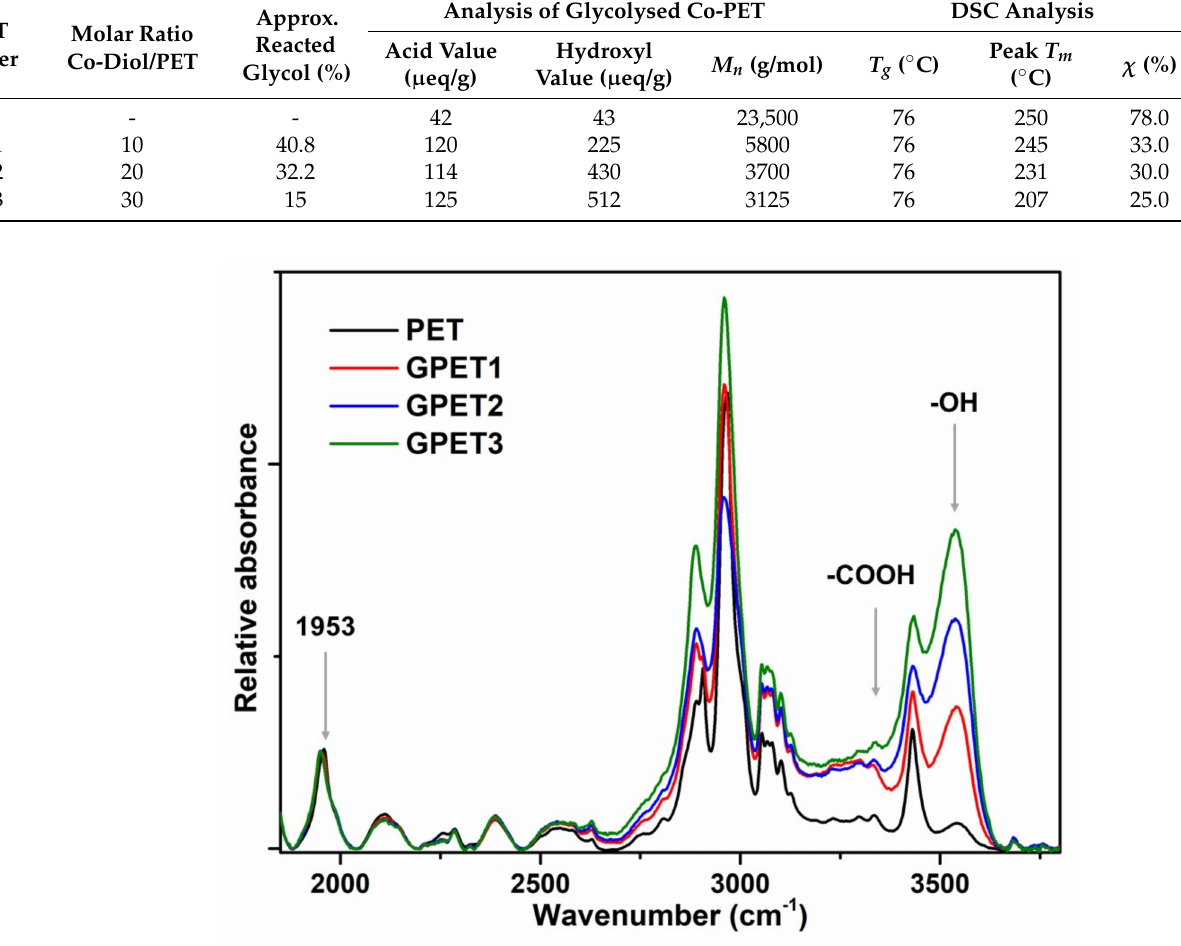
Figure 4. FTIR analysis of extruded and glycolysed